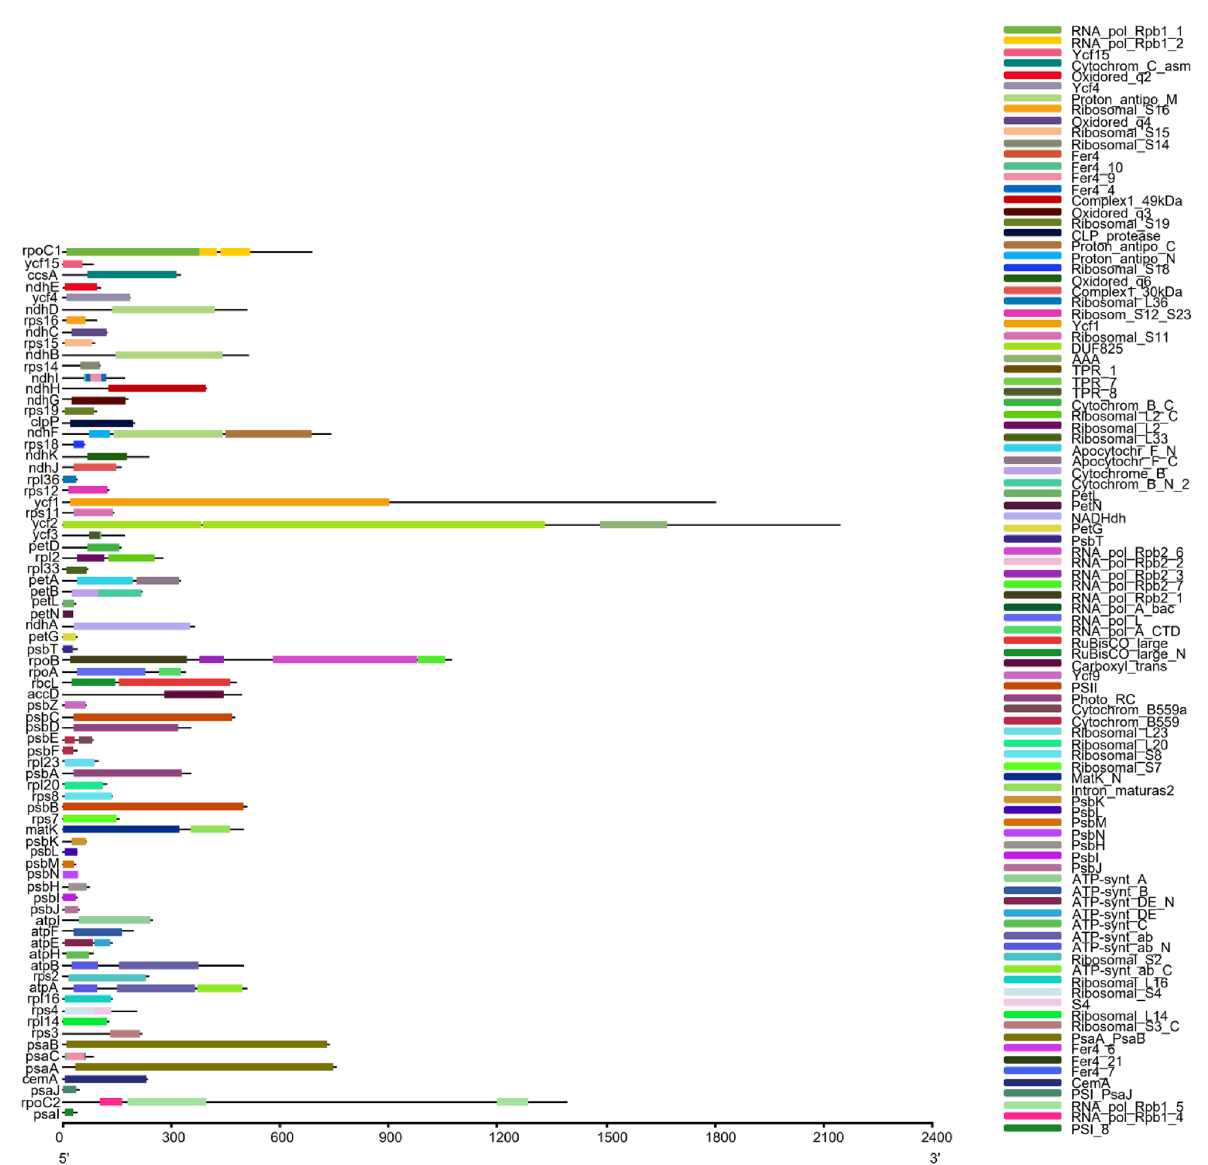
Figure 2. Protein functional domains of protein-coding genes in Paeoniaceae